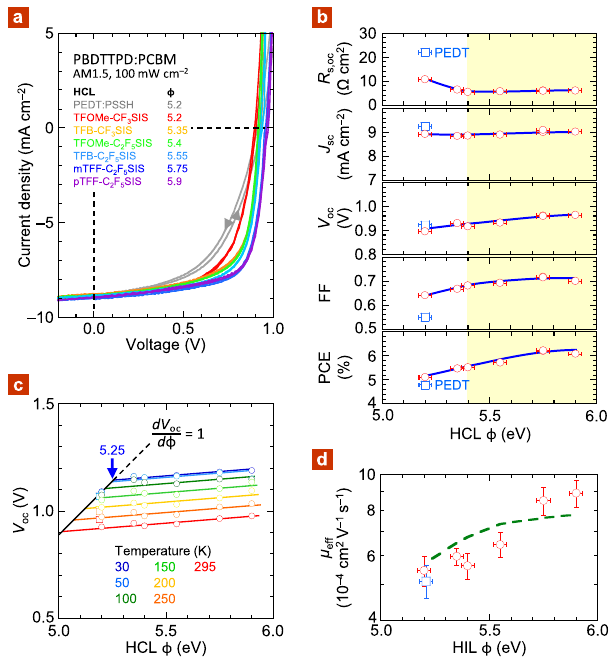
Fig. 5 Characteristics of PBDTTPD:PCBM solar cells and hole-only diodes. a JV curves for different hole collection layers in cell con fi guration: ITO/20-nm HCL/100-nm PBDTTPD:PCBM (1:1.5 w/w)/30-nm Ca/Al, measured under simulated AM1.5 G irradiance of 100 mW cm − 2 , spectral mismatch corrected, 298 K. b Cell parameters plotted against work function of hole collection layer. Data give population mean; standard error is smaller than symbol size. Blue lines are guides to the eye for TAF series. Yellow region corresponds to Ohmic regime. c V oc ( ϕ , T ) plot measured at 1.0 sun. V oc data are averaged for forward and reverse sweeps. Typical uncertainty: ±0.01V at high ϕ ; ±0.05V at low ϕ . Colored lines are fi ts with constant slope of 80 mV eV ‒ 1 . The black line ( dV oc d ϕ = 1) is anchored by low- temperature data set for ϕ = 5.2 eV. Below 50 K, V oc approaches V o , which is the low-temperature V bi . d Plot of effective hole mobility against work function of hole injection layer in hole-only diodes: ITO/20-nm HIL/ 100 ─ 120-nm PBDTTPD:PCBM (1:1.5 w/w)/Ag, for TAF series (circles) and PEDT:PSSH (square) as HIL. Error bar corresponds to standard error of mean. Green dashed line is from Gaussian disorder theory (see